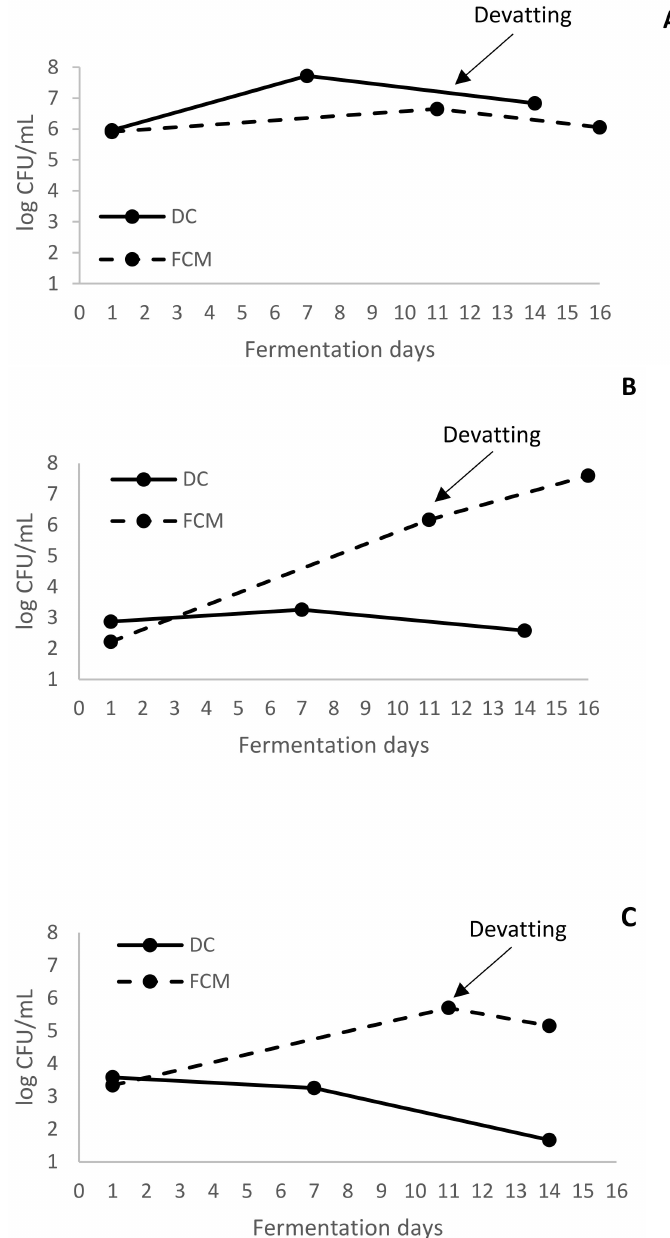
Figure 2. Evolution of the yeasts ( A ), lactic bacteria ( B ), and acetic bacteria ( C ) populations in the must during the fermentation of wines made by destemming and crushing (DC) and by carbonic maceration